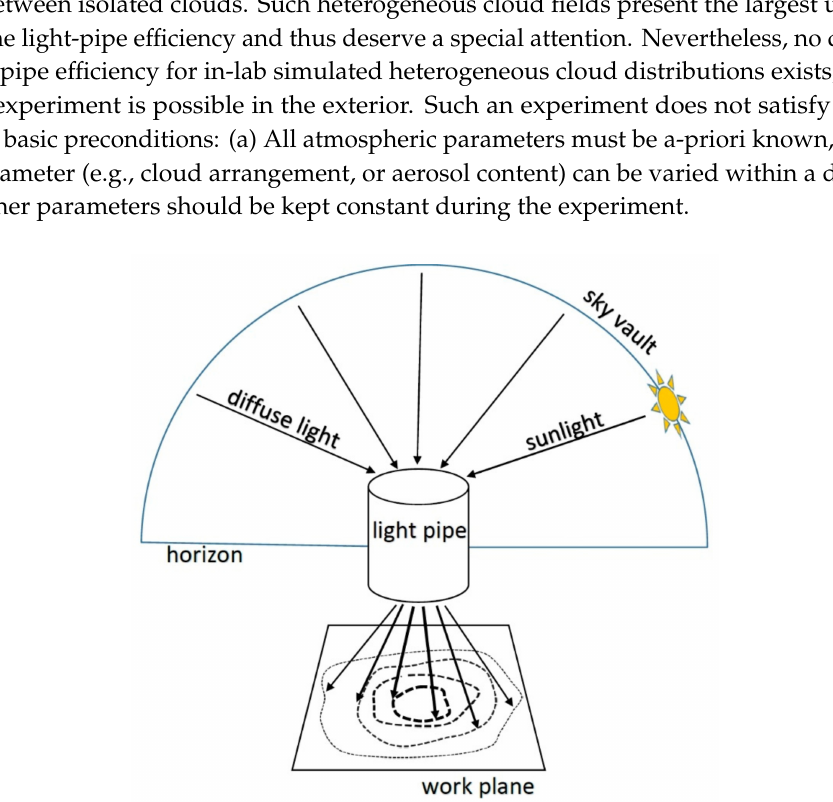
Figure 1. The schematic view of the configuration of the sky, light pipe and work